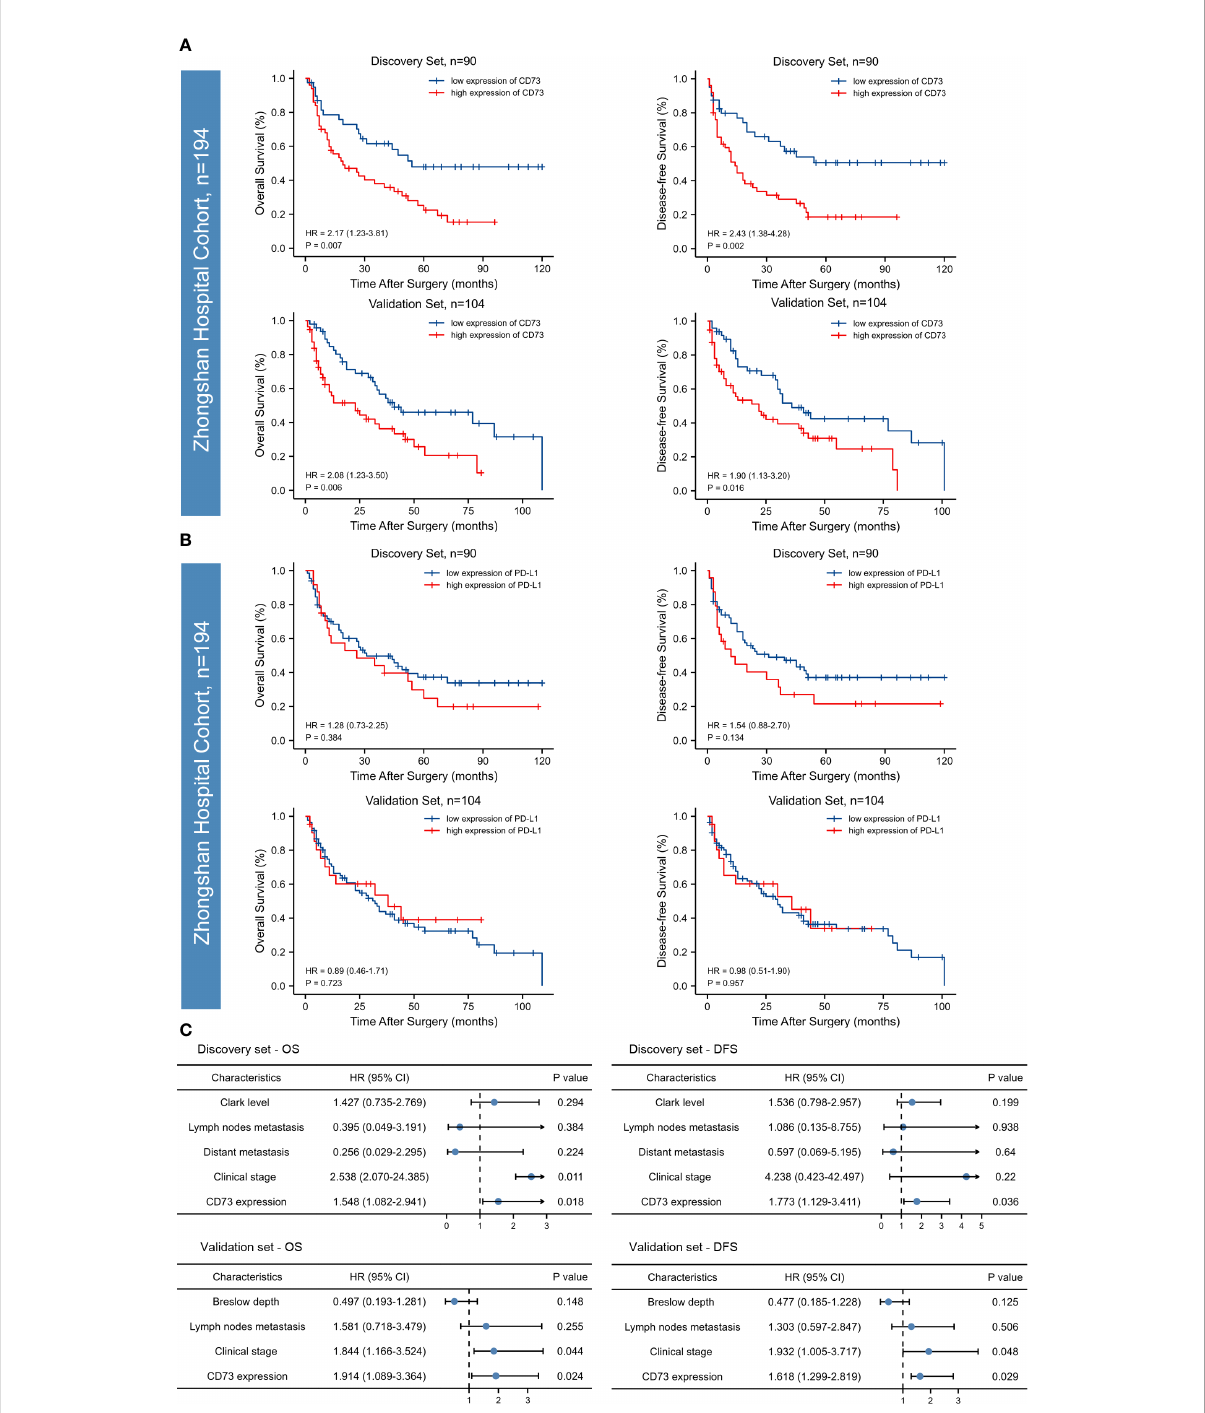
FIGURE 2 Kaplan-Meier survival curves and forest plots for OS and DFS of patients with melanoma. High CD73 expression was signi fi cantly associated with poor overall survival (OS) and disease-free survival (DFS) in the discovery set and the relevance was con fi rmed in an independent validation set (A) . PD-L1 expression in both of the discovery and validation sets failed to stratify OS and DFS (B) . According to the Multivariate Cox regression analysis, CD73 could serve as an independent predictor of adverse clinical outcomes (C) . The p-values were determined via log-rank